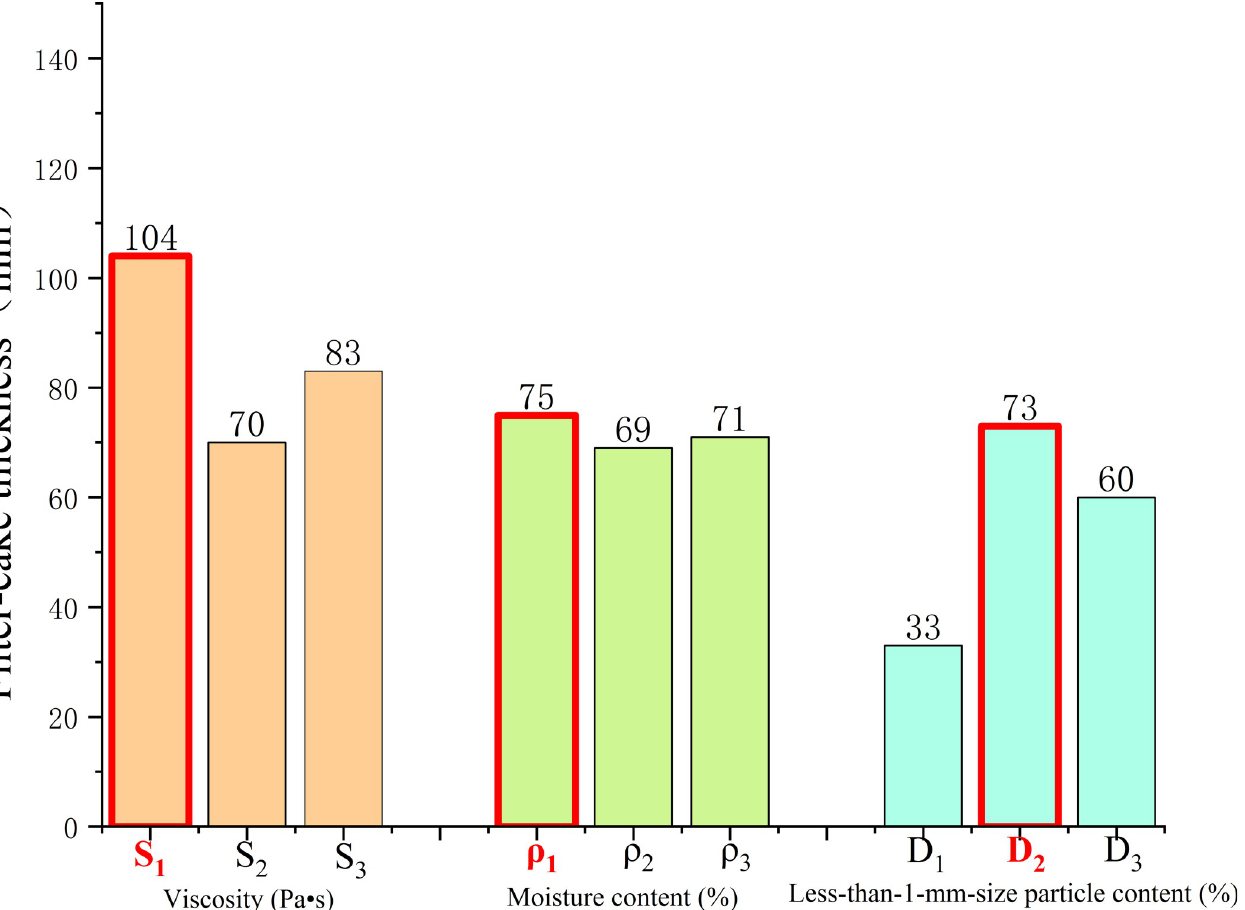
Fig 13. Analysis of the influence of mud film thickness on weathered red-bed